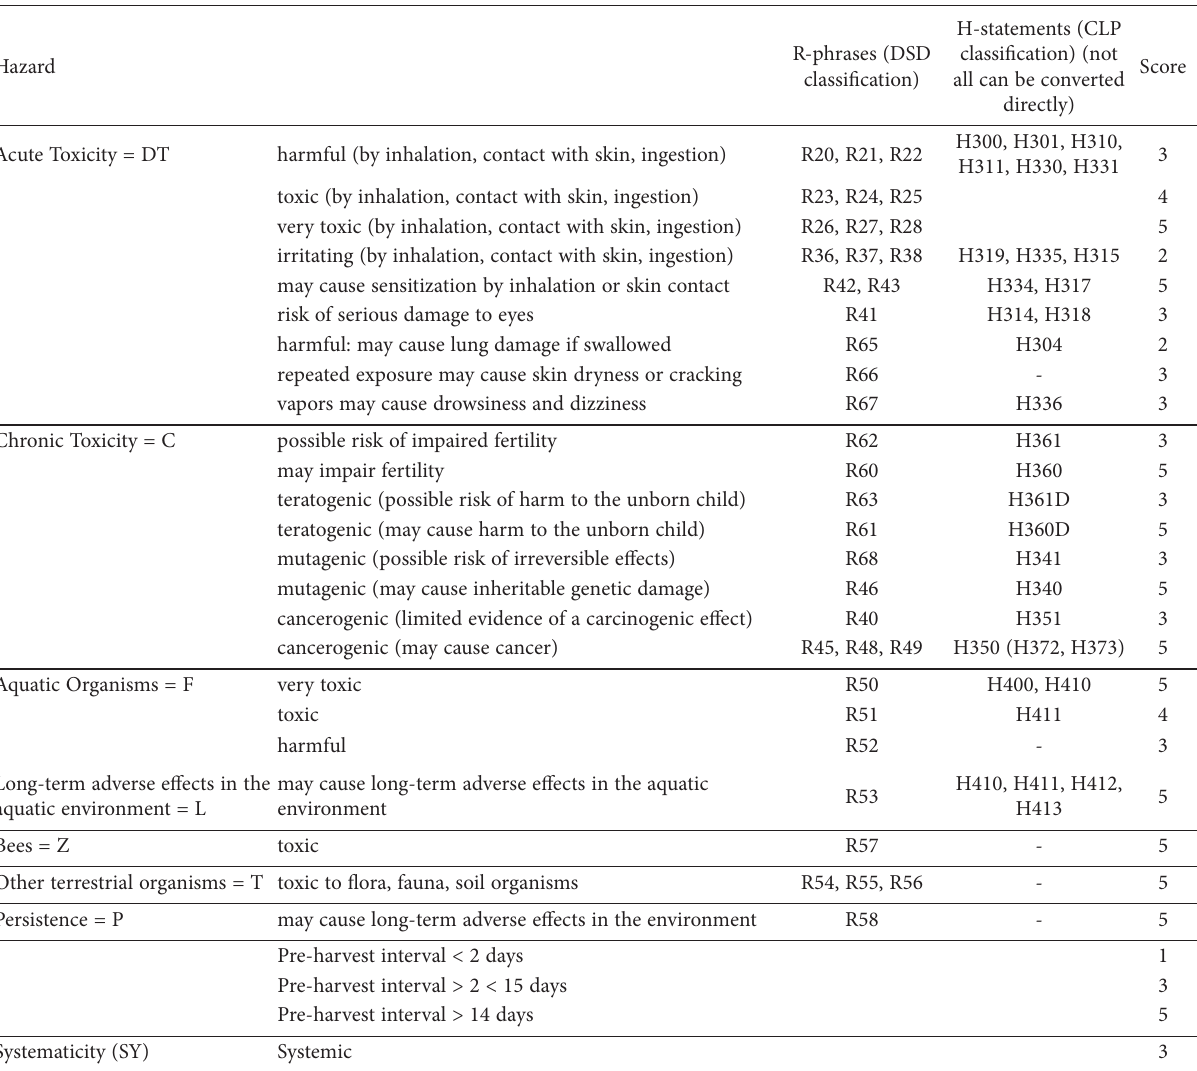
Table A1.1. Scoring system used to develop the new environmental impact quotient for pesticides (newEIQ). Scores range from 1 (no